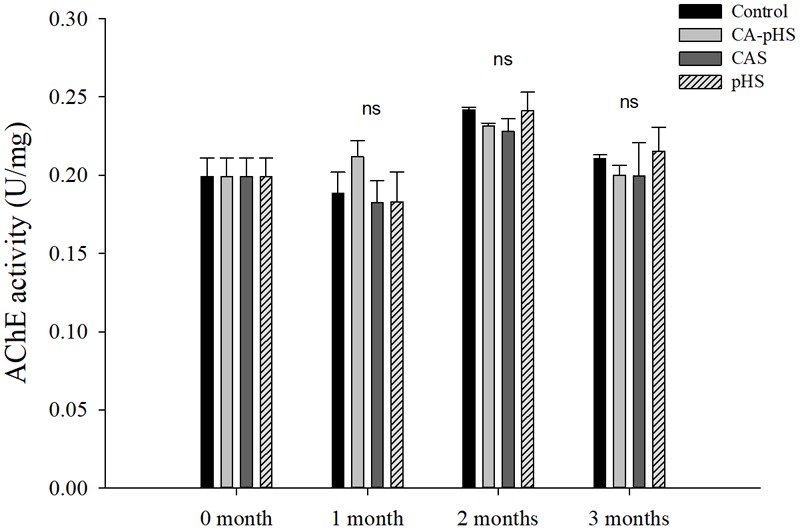
Juvenile of S. constricta acetylcholinesterase (AChE) activity levels in the long-term toxicity test. Bars (mean ± SE, n = 3) with different letters denote significant differences (p < 0.05) among the four groups in each month. The letters “ns” indicate insignificant difference among the four groups in each month.